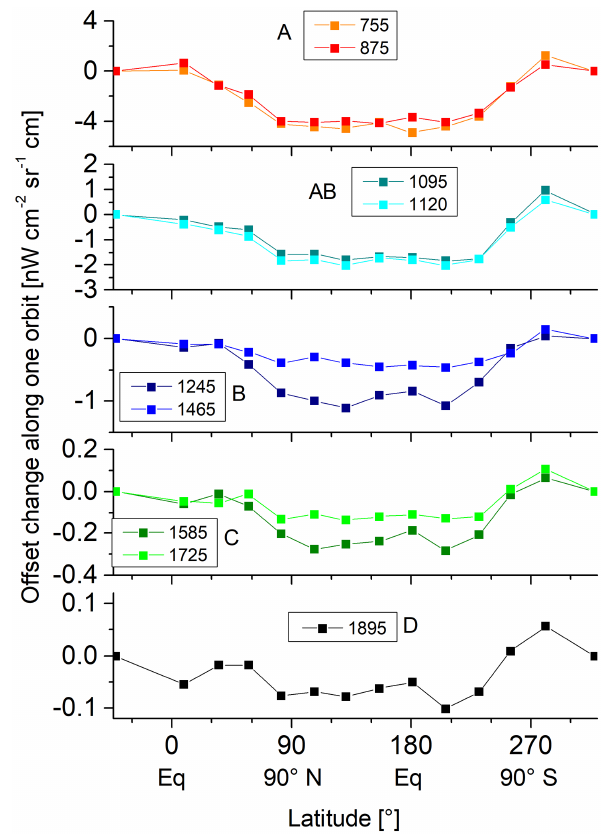
Figure 9. Variation of the instrument offset along the orbit for se- lected wavenumbers in November 2003 (FR